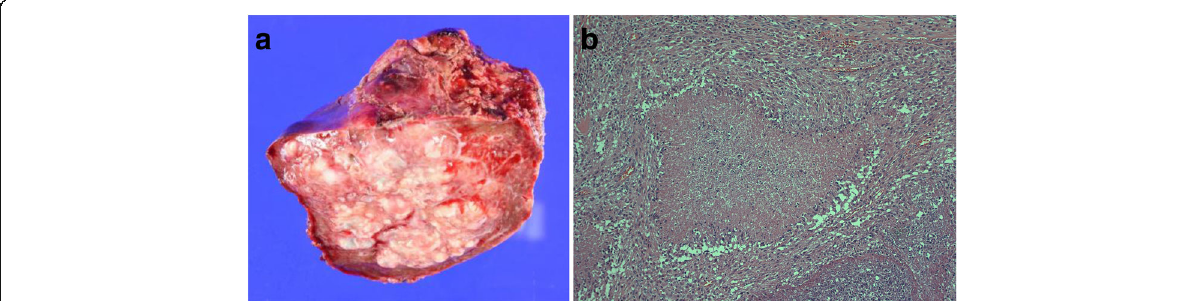
Fig. 2 a Photograph of resected specimen. The resected liver weighed 290 g. The abscess was multiloculated and full of light green, malodorous, and viscous pus. b Histopathological findings. Histopathological examination showed epithelioid cell granuloma with caseous necrosis consistent with the diagnosis of CGD (H&E staining,